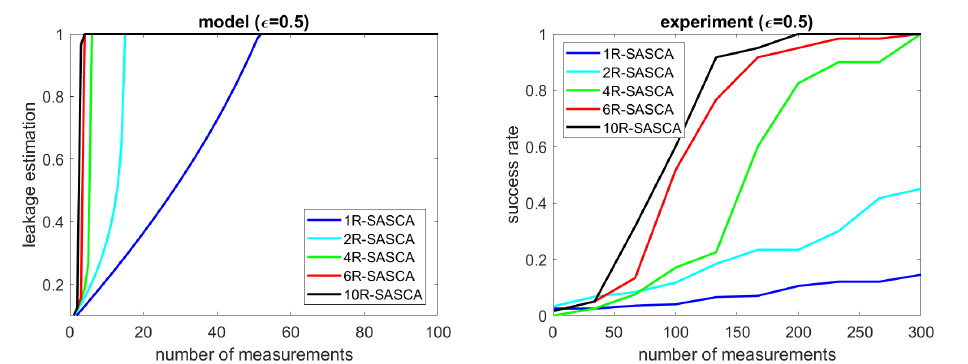
Figure 10: Leakage bounds and success rates of experimental SASCA with up to ten rounds against an unprotected AES implementation in a unknown plaintext scenario.